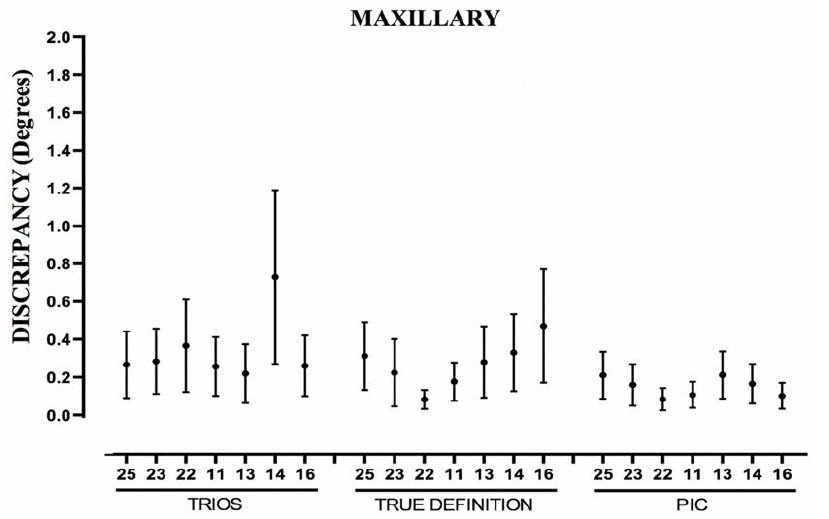
Figure 7. Boxplot showing measurements of relative angulations of abutments of maxillary arch. Abutment 26 is used as reference. Point represents mean error; line represents standard deviation.